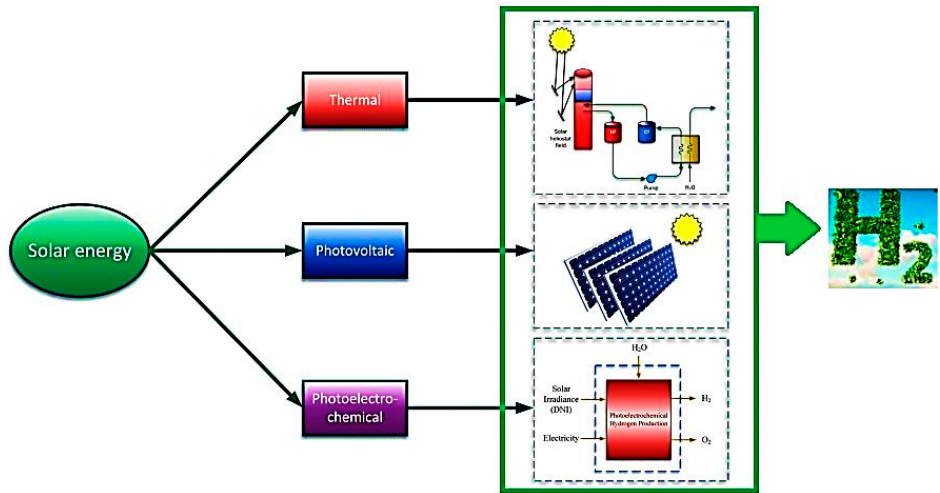
Figure 7. The classification of solar energy to produce hydrogen.